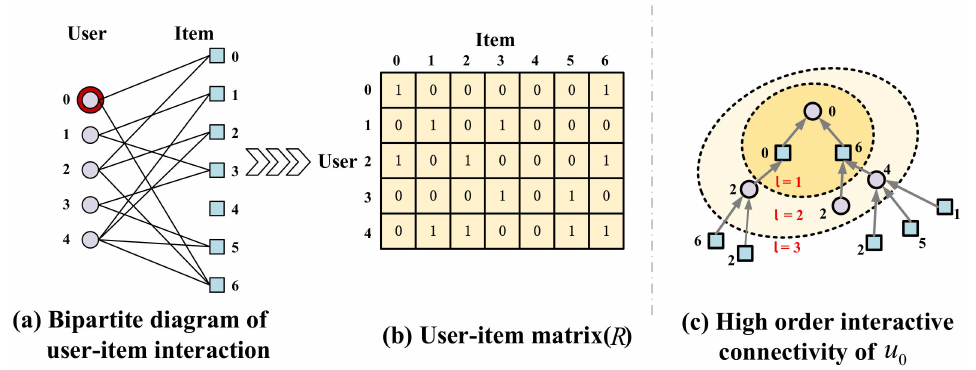
Figure 5. User–item